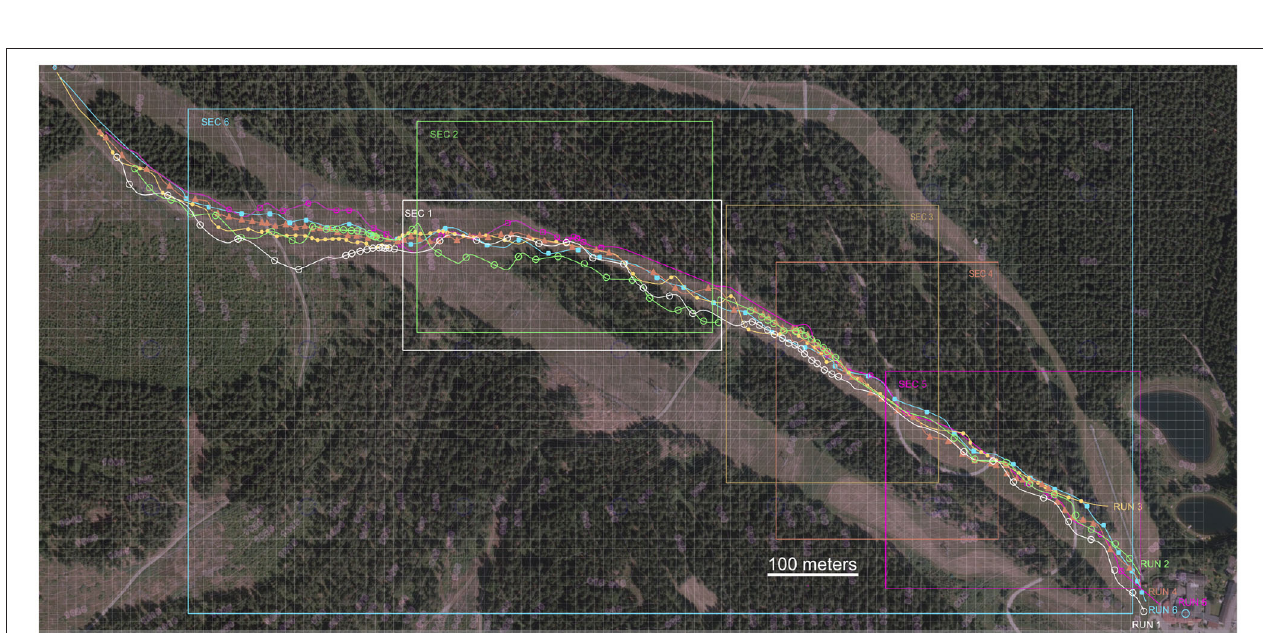
FIGURE 9 | Overview of six runs—each section marks the range of the detailed run analysis as shown in the diagrams from Figures 6 – 8 .